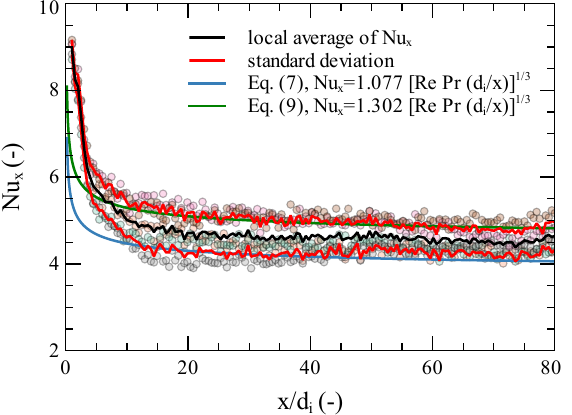
Figure 11. Measured values for one Reynolds number (Re = 197) depending on the distance from the entrance to the measuring zone. At the entrance to the measurement section, we can see a larger deviation. The average standard deviation of the data is 5.49% considering a 95% confidence interval.